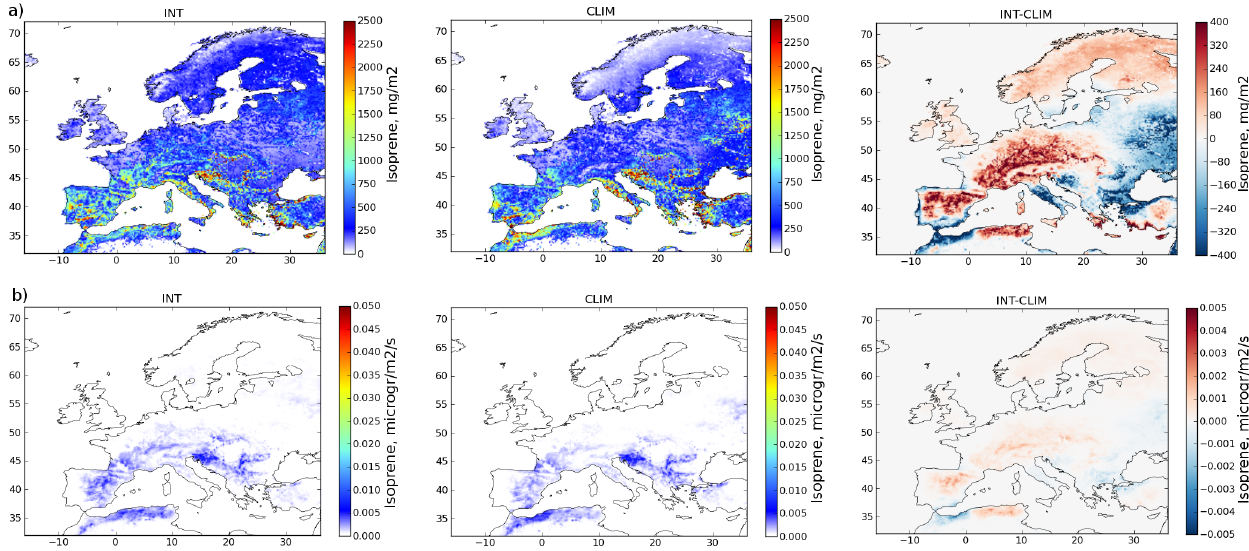
Fig. 5. (a) Emissions of isoprene for the summertime period, averaged for 2004–2008 in the INT (left) and CLIM (middle) simulations. Differences between INT and CLIM are shown on the right figure. (b) Deposition flux (µ g m − 2 s − 1 ) of isoprene, averaged for the summertime of INT and CLIM simulations.